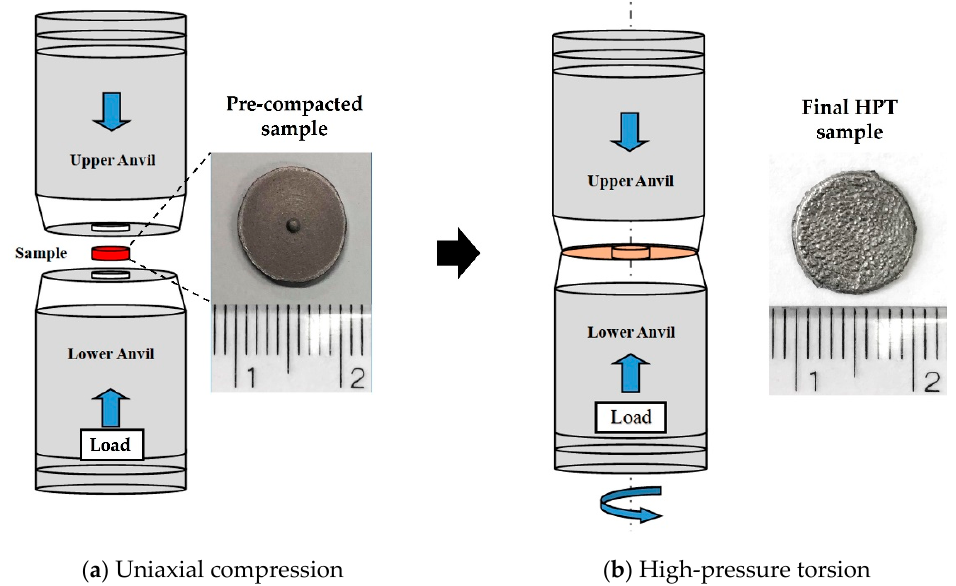
Figure 1. SEM micrographs (backscattered electrons signal) of the Mg-Ni-Nb 2 O 5 mixture after mild milling processing. Bright particles correspond to Ni and Nb 2 O 5 , while the larger, gray particles correspond to Mg. ( a ) Low magnification image showing overall dispersion of Ni and Nb 2 O 5 particles on the surface of the Mg powders. ( b ) Image at higher magnification in which individual and agglomerated Ni and Nb 2 O 5 particles can be observed more clearly.